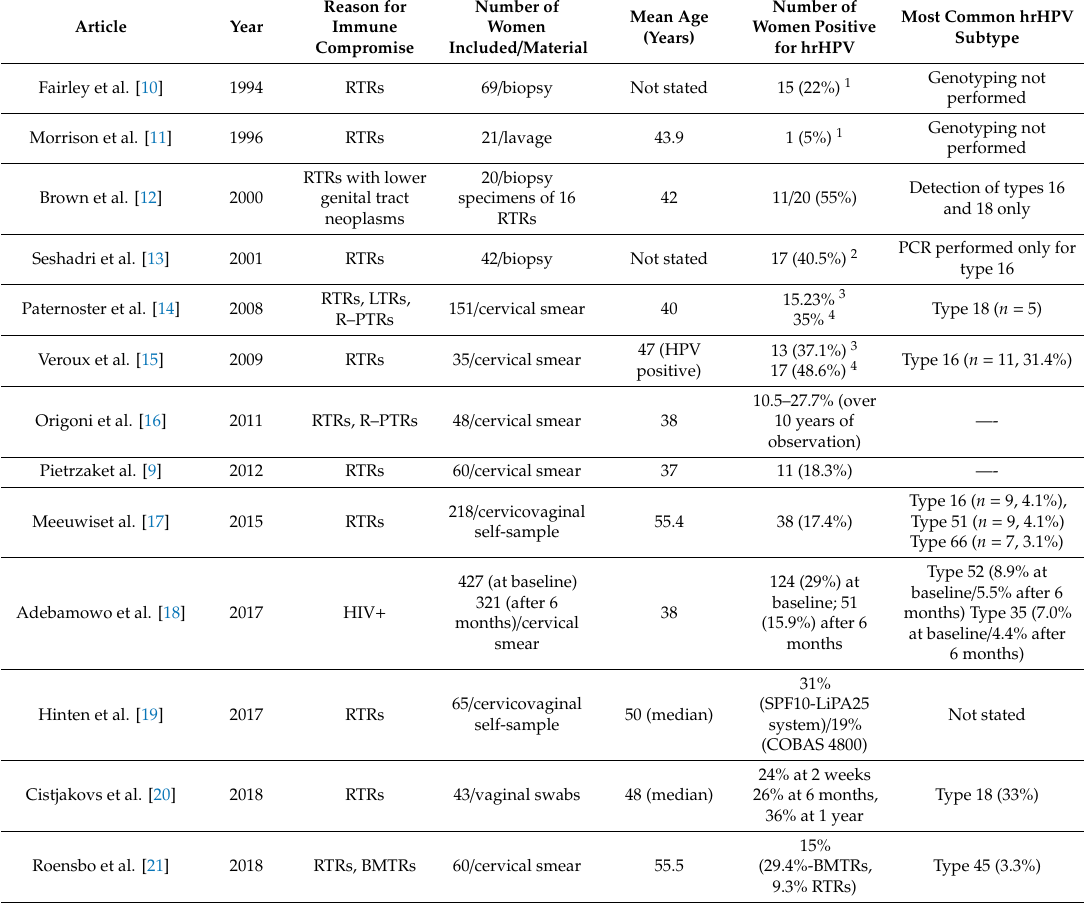
Table 5. Studies on the prevalence of HPV among immunocompromised